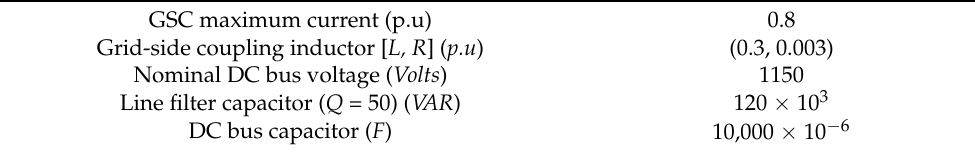
Table A4. Converter data.